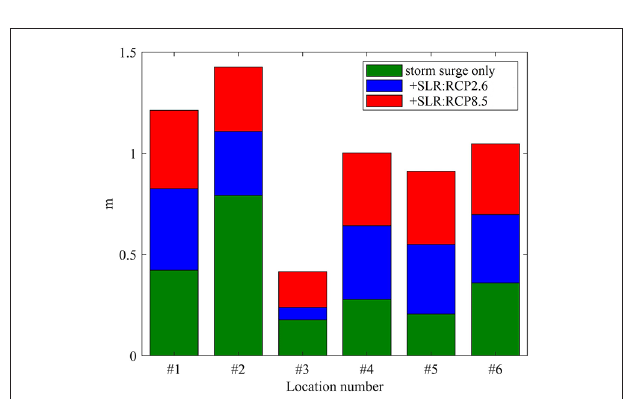
FIGURE 11 | Maximum inundation height in selected six locations (unit: